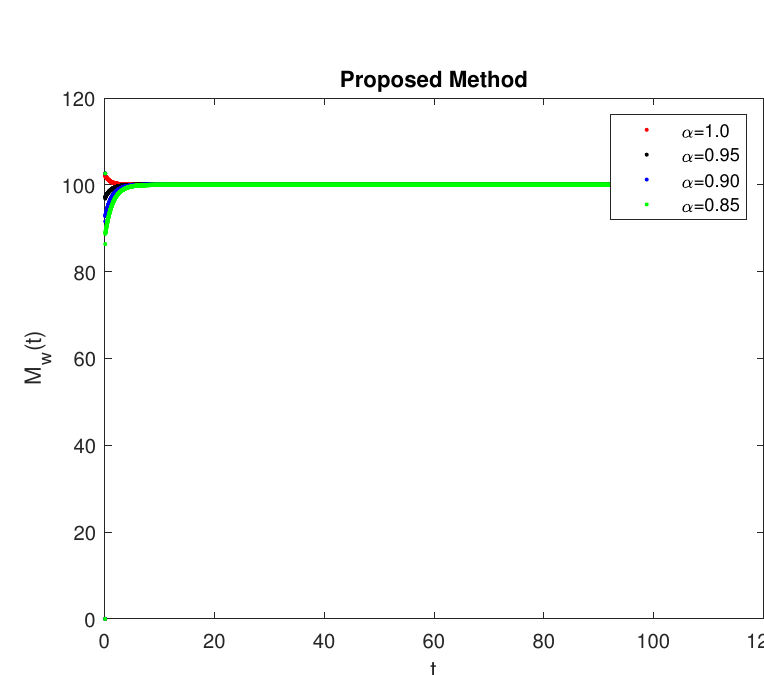
Figure 24: Numerical simulations for τ = 0.98 for Caputo-Fabrizio